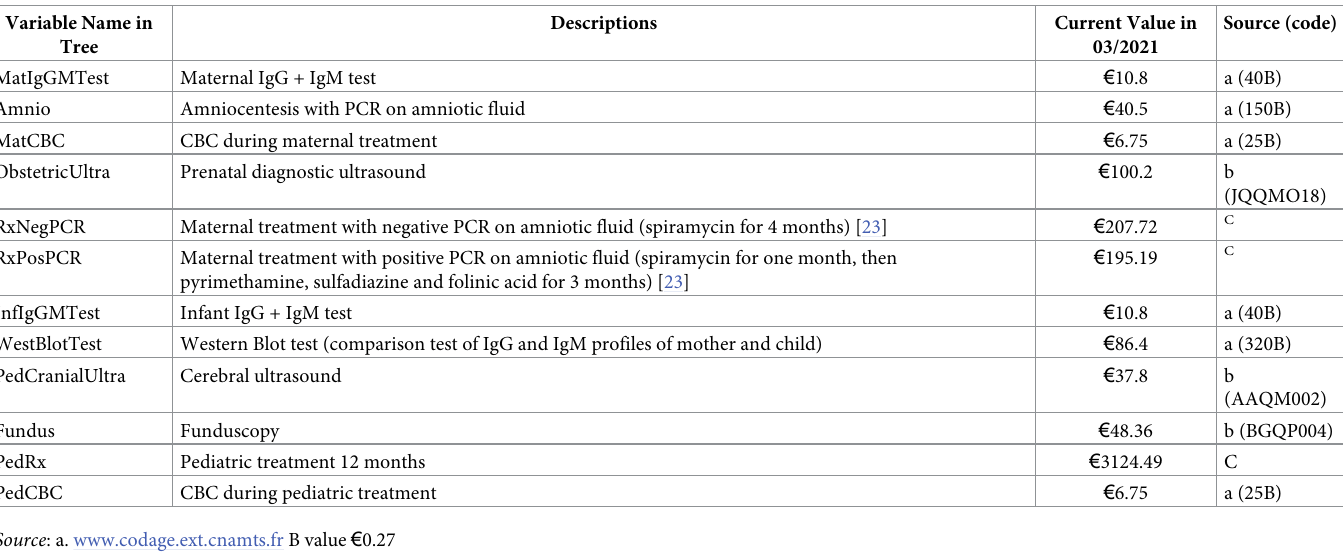
Table 3. Test and medication